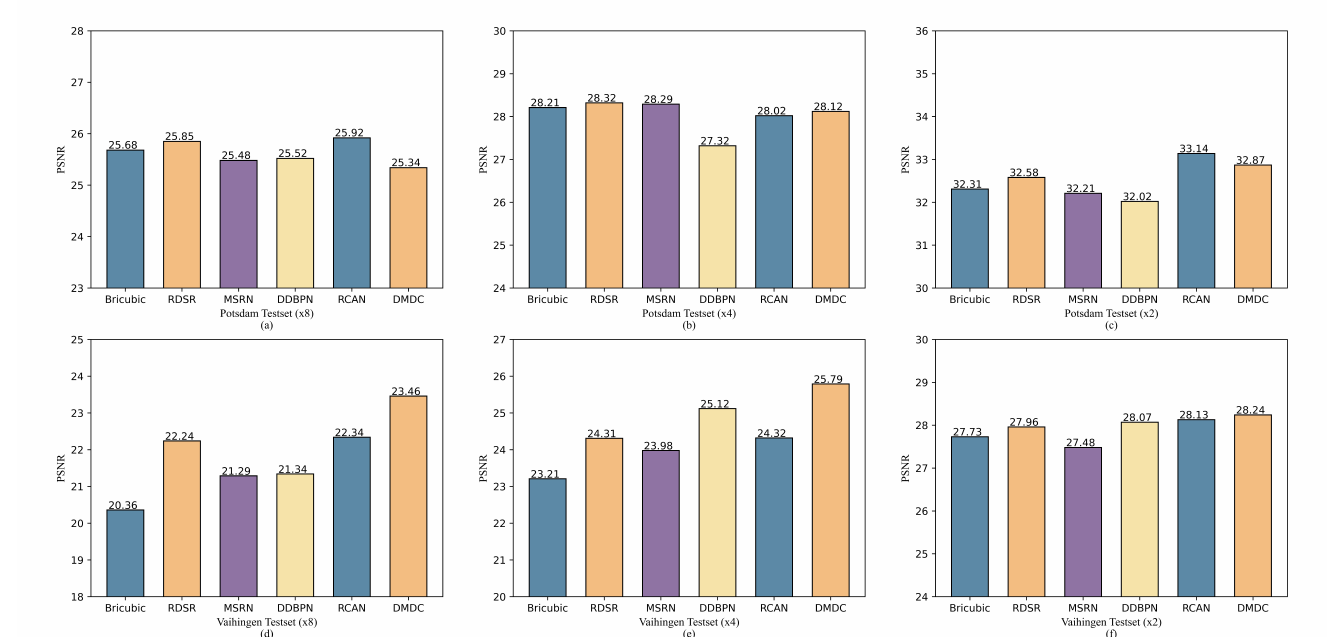
Figure 9. Super-resolution histograms of × 8, × 4, × 2 magnification ratios on the ISPRS Potsdam (first row) and Vaihingen (second row) datasets. Where the abscissa is the baseline, the state-of-the-art method, and DMDC, and the ordinate reports the quantitative results of the PSNR metric. Note that we trained and tested in Potsdam. Then we transferred directly to Vaihingen for testing without any training or fine-tuning. The PSNR indicator histograms in Figure 9 are: ( a ) Postdam Testset ( × 8), ( b ) Postdam Testset ( × 4), ( c ) Postdam Testset ( × 2), ( d ) Vaihingen Testset ( × 8), ( e ) Vaihingen Testset ( × 4), and ( f ) Vaihingen Testset ( ×